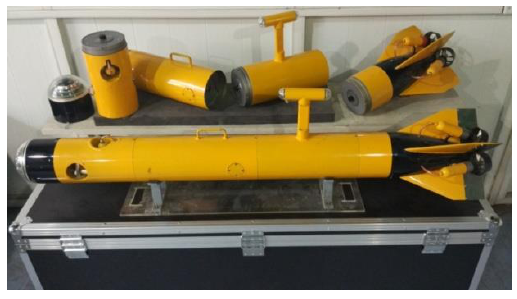
Figure 1. Modular ZFAUV.